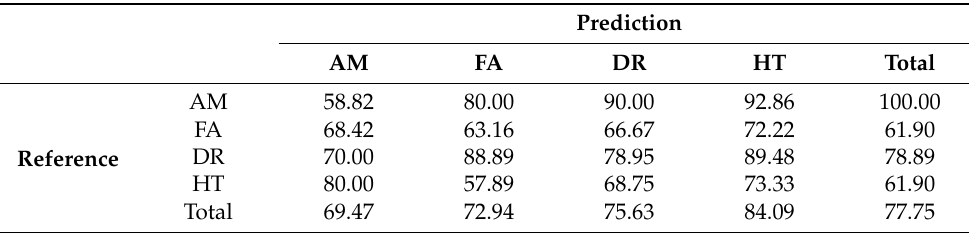
Table 6. Confusion matrix of classification results with the highest weighted accuracy. The value indicates the ratio of samples that were correctly predicted to reference samples.